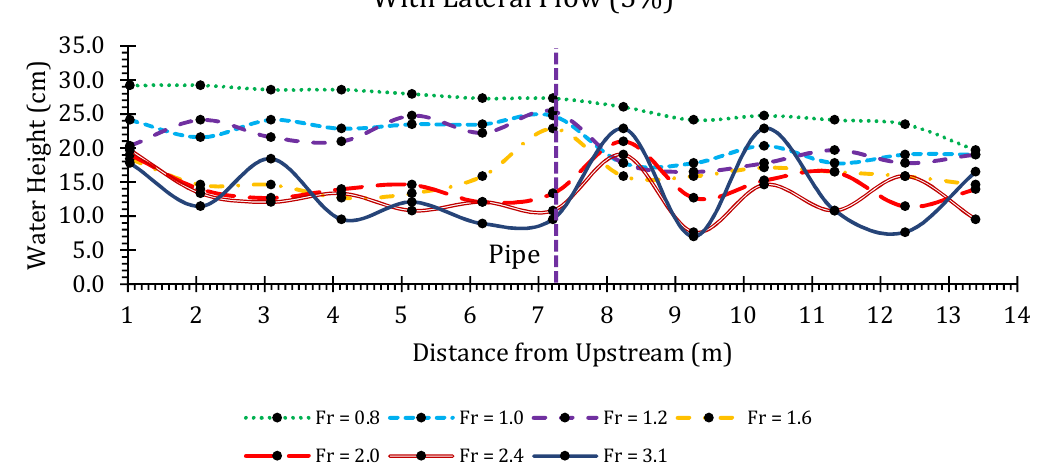
Figure 9. Water heights in the wide channel, with 5.0% lateral flow.